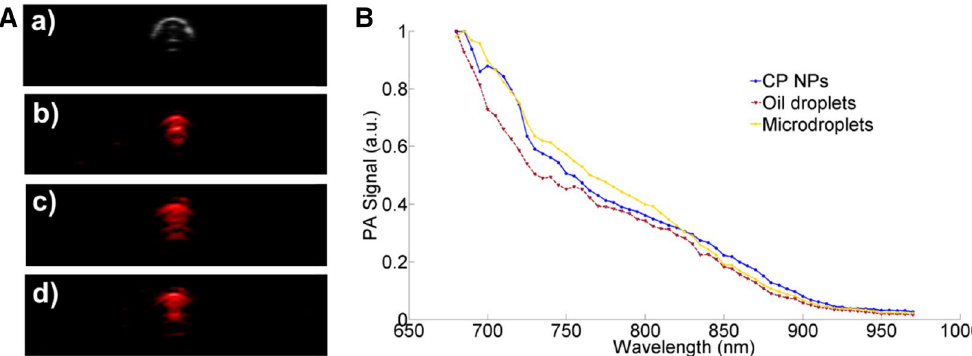
Figure 2. PA images and spectrums of three samples: ( A ) Imaging results of samples in test-tubes: (a) The ultrasound image of the tube filled with CP NPs. (b–d) are the PA images of CP NPs, oil droplets and hydrogel microdroplets with CP NPs inside, respectively. The illumination wavelength was 750 nm. ( B ) The normalized PA spectra of these three samples. There is no significant change in the spectra when CP NPs are covered by both oil and